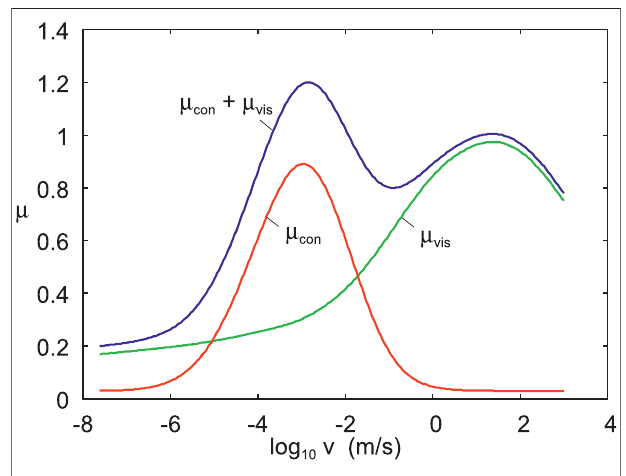
FIGURE 1 | The contribution to the friction coef fi cient from viscoelastic deformations μ